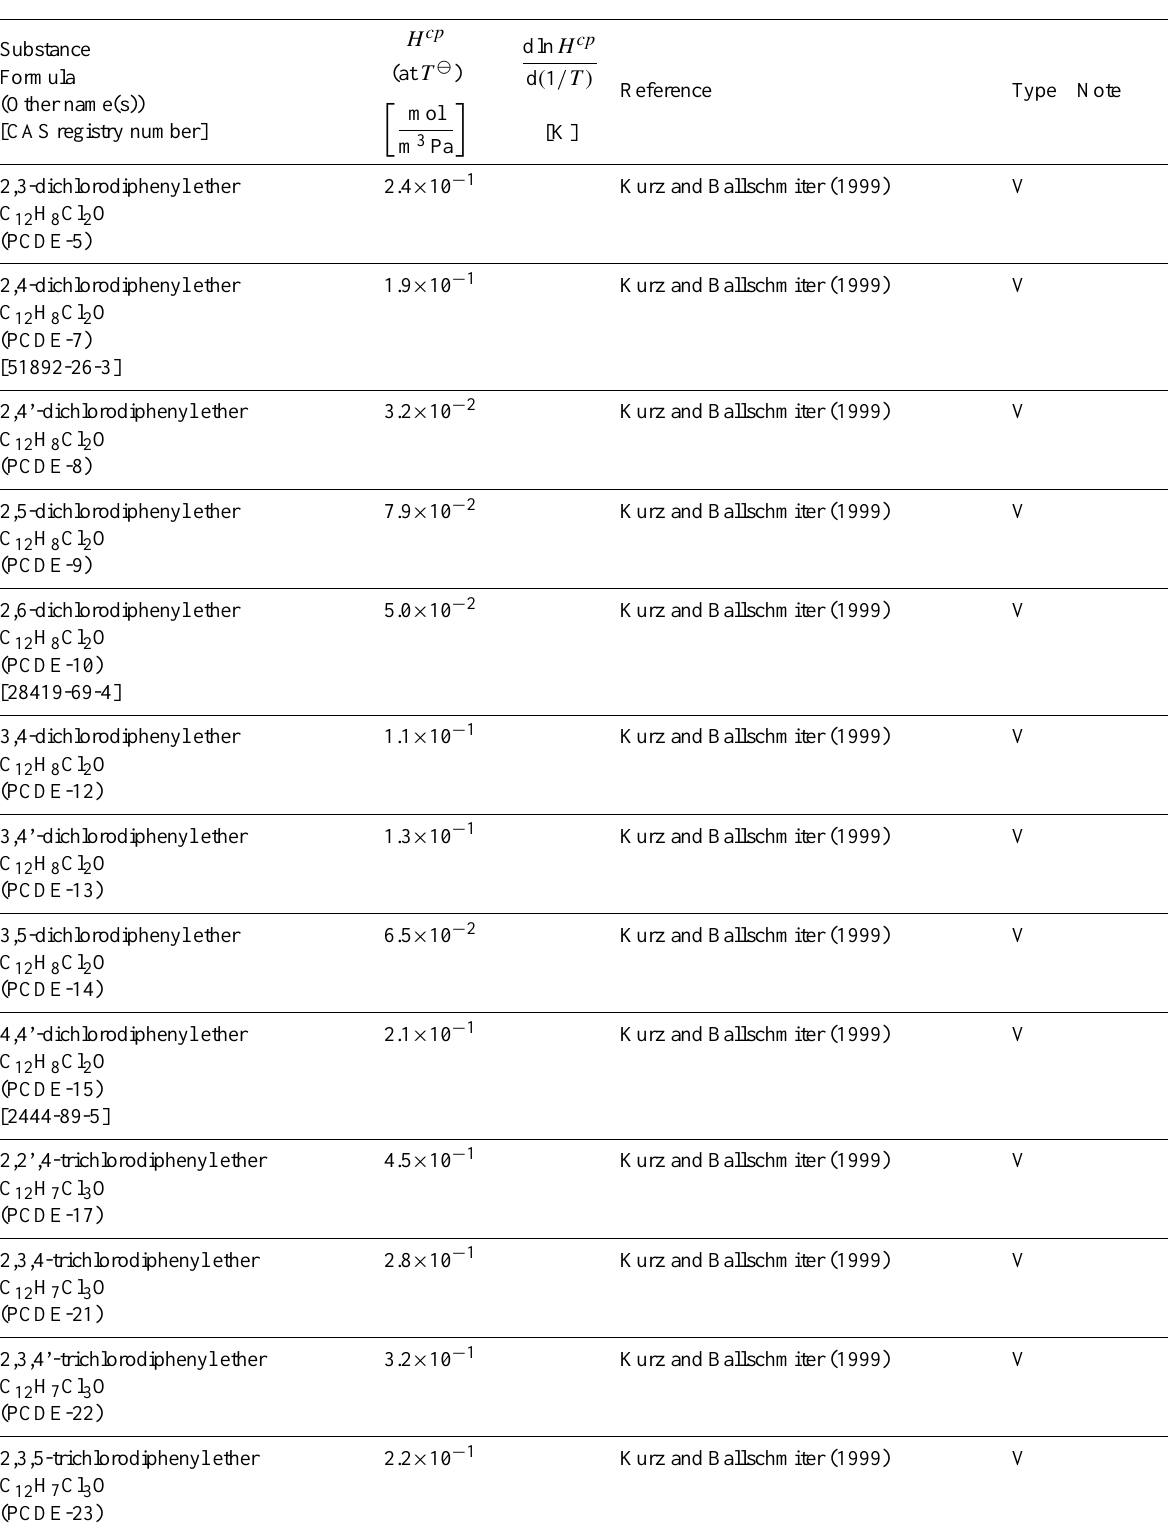
Table 6: Henry’s law constants for water as solvent